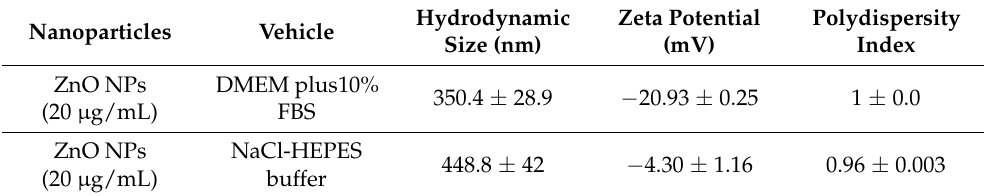
Table 1. ZnO NPs physicochemical characteristics. ZnO NPs were suspended in DMEM plus 10% FBS and NHB at 20 µ g/mL and were vortexed at 60 Hz for 10 min for subsequent reading on the Zetasizer Nano-ZS90